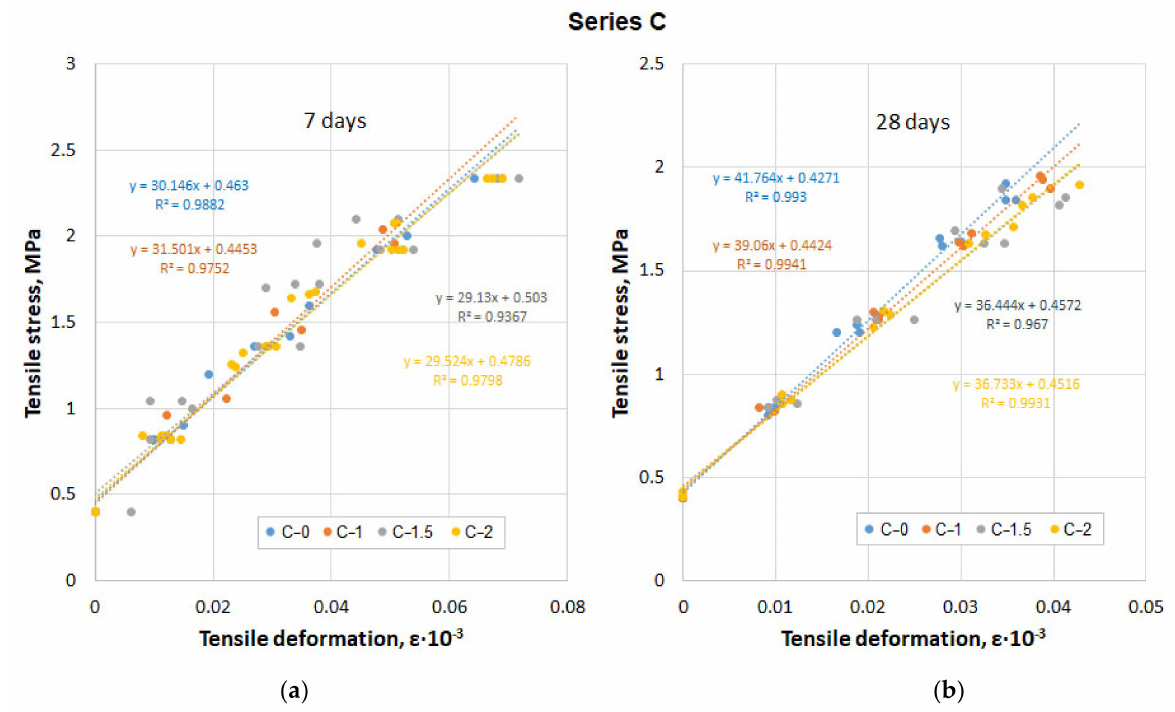
Figure 9. Results of measuring tensile deformation of series C specimens depending on the applied stress ( a ) 7 days; ( b ) 28 days.